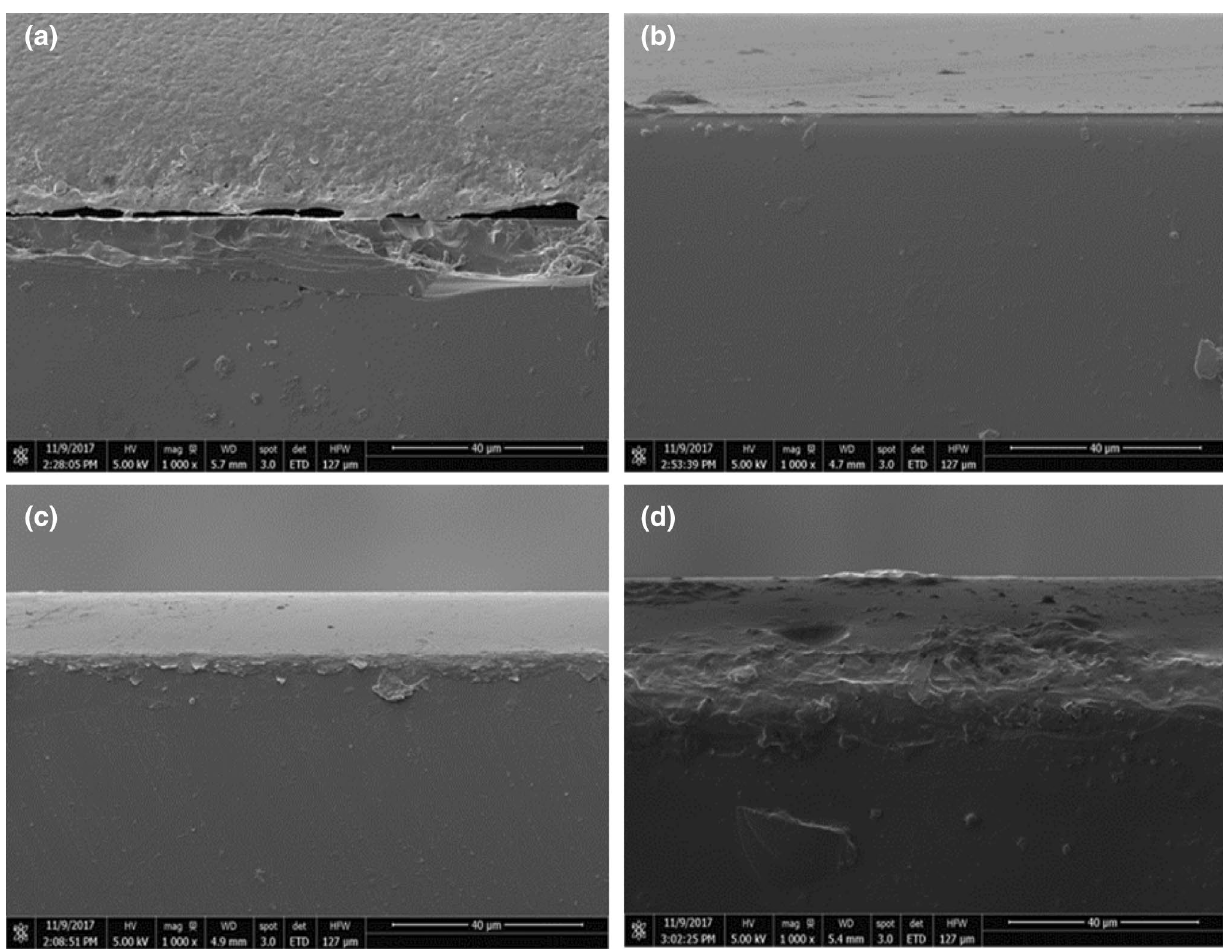
Fig. 12 Cross-sectional SEM images of the DSSC cells encapsulated with; a PVDC, b PU, c PU/PVDC, d PU/PVDC/CNC resents the encapsulants, whereas the bottom layer is the glass substrate